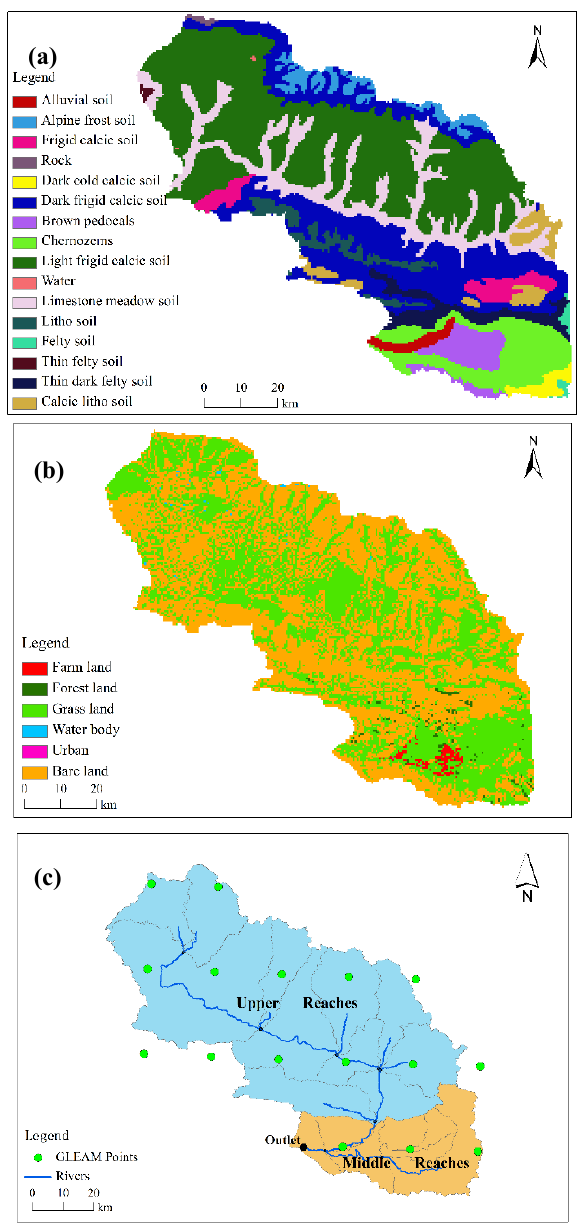
Figure 2. Soil and Water Assessment Tool (SWAT) model basic data. ( a ) Soil types; ( b ) land use types; ( c ) sub-basins.